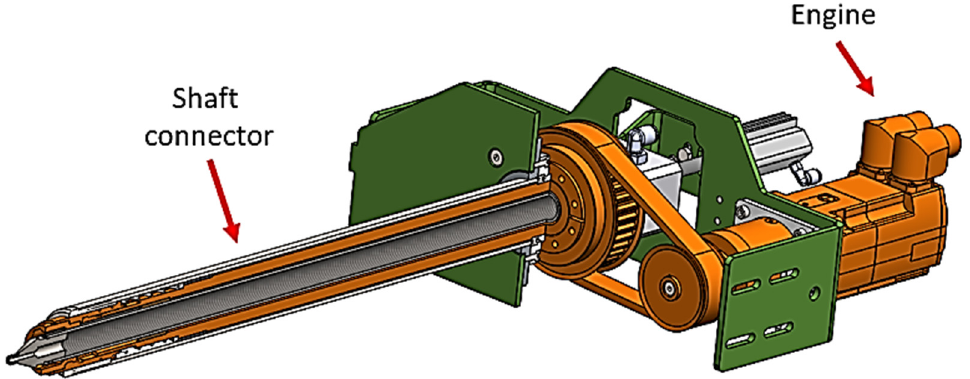
Figure 9. Sectional view of the mechanism responsible for rotating the expandable pneumatic shaft.